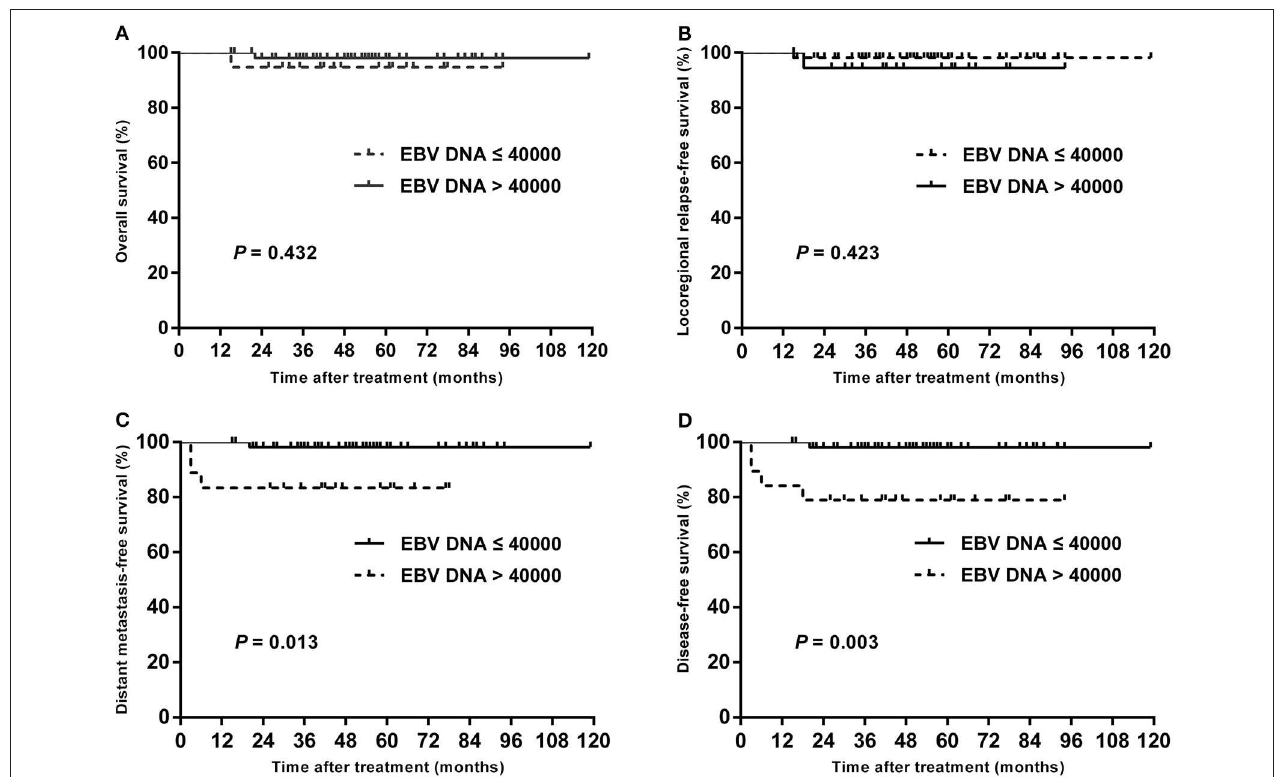
FIGURE 3 | Kaplan–Meier estimate of the OS (A) , LRRFS (B) , DMFS (C) , and DFS (D) of T1–T3 children and adolescent NPC patients according to pretreatment EBV DNA